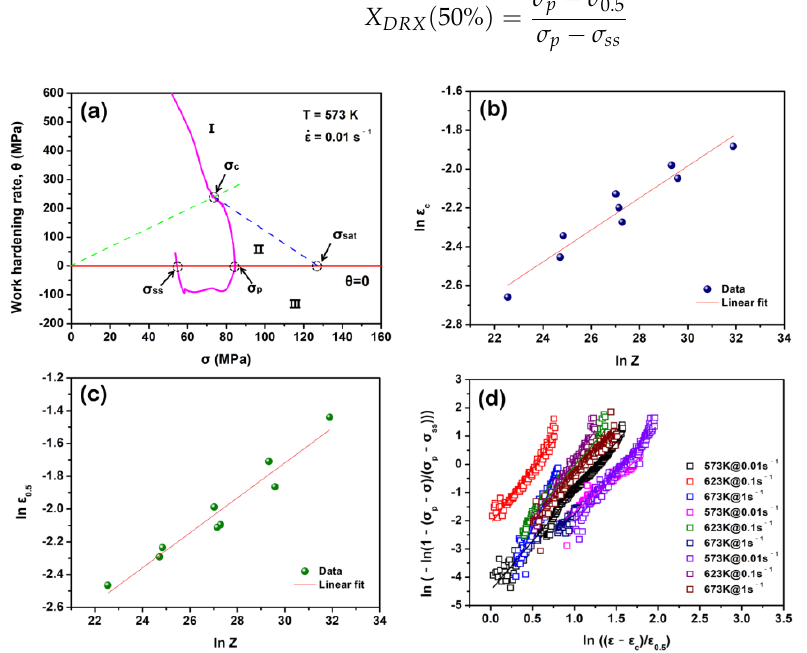
Figure 9. ( a ) 𝜃 − 𝜎 curve at 573 K and 0.01 s − 1 ; ( b ) relationship between ln 𝜀 𝑐 and ln Z ; ( c ) rela- Figure 9. ( a ) θ - σ curve at 573 K and 0.01 s − 1 . Note that it is divided into three stages marked by I, II tionship between ln 𝜀 0.5 and ln Z ; ( d ) ln ( − ln (( 1 − (𝜎 𝑝 − 𝜎)/(𝜎 𝑝 − 𝜎 𝑠𝑠 )))) as a function of ln ((𝜀 − and III, respectively; ( b ) relationship between ln ε c and ln Z ; ( c ) relationship between ln ε 0.5 and ln Z ; 𝜀 𝑐 )/𝜀 0.5 ) . (cid:0) (cid:1) (cid:0) (cid:1) ))) σ p − σ σ p − σ ss ( d ) ln ( − ln ((1 − / as a function of ln (( ε − ε c ) / ε 0.5 )